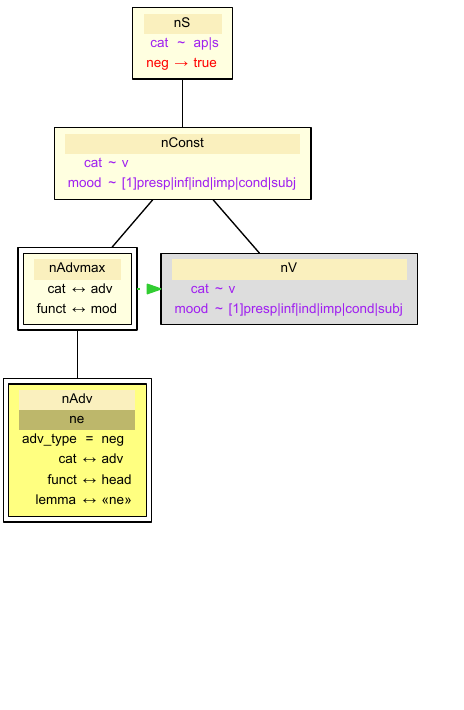
nAdv ne adv_type = neg cat ↔